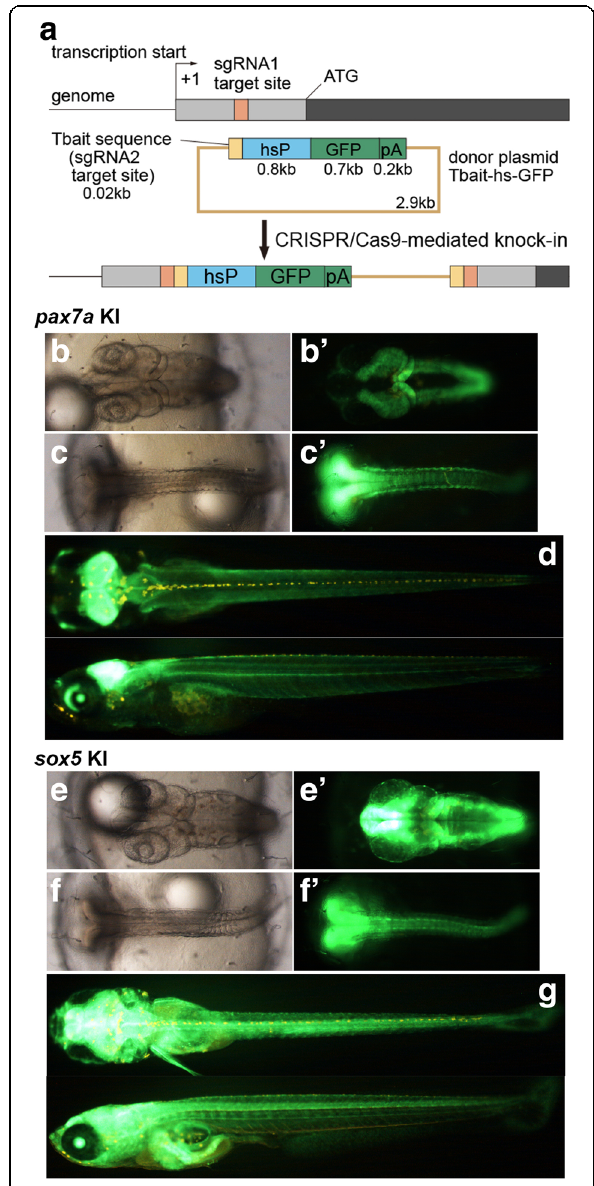
Fig. 4 Generation of Tg[pax7a-hs:GFP] and Tg[sox5-hs:GFP] fish. ( a ) Schematic of the knock-in strategies. The sgRNAs for pax7a or sox5 were designed to target a sequence upstream of the initiation methionine that corresponds to the 5 ′ untranslated region. ( b – d ) Tg[pax7a-hs:GFP]. ( e – g ) Tg[sox5-hs:GFP]. ( b, b', c, c', e, e', f, f' ) Dorsal views of the head ( b, b', e, e' ) and the trunk ( c, c', f, f' ) at 2 dpf in the bright field ( b, c, e, f ) and in fluorescence ( b', c', e', f' ). ( d, g ) Dorsal (upper) and lateral (lower) views at 9 dpf. In Tg[pax7a-hs:GFP] embryos, GFP is expressed in the tectum, hindbrain, anterior neural tube ( b' ), and muscles ( c' ). These fluorescent signals are maintained in the hatchlings ( d ). In Tg[sox5- hs:GFP] embryos, GFP is expressed in a range of the central nervous system (CNS) from the forebrain to hindbrain ( e' ), and in neural tubes and the premigratory neural crest in a dotted manner ( f' ). At 9 dpf, additional fluorescent signals are observed in the pectoral fins, olfactory bulbs, and presumable xanthophore progenitors on the dorsal body surface ( g ; see also Additional file 3: Fig. S1C –